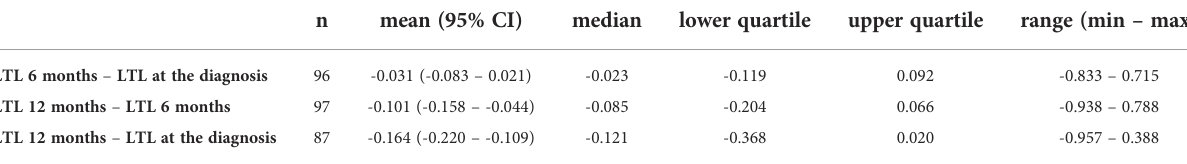
The table compares delta LTL values between time point intervals.